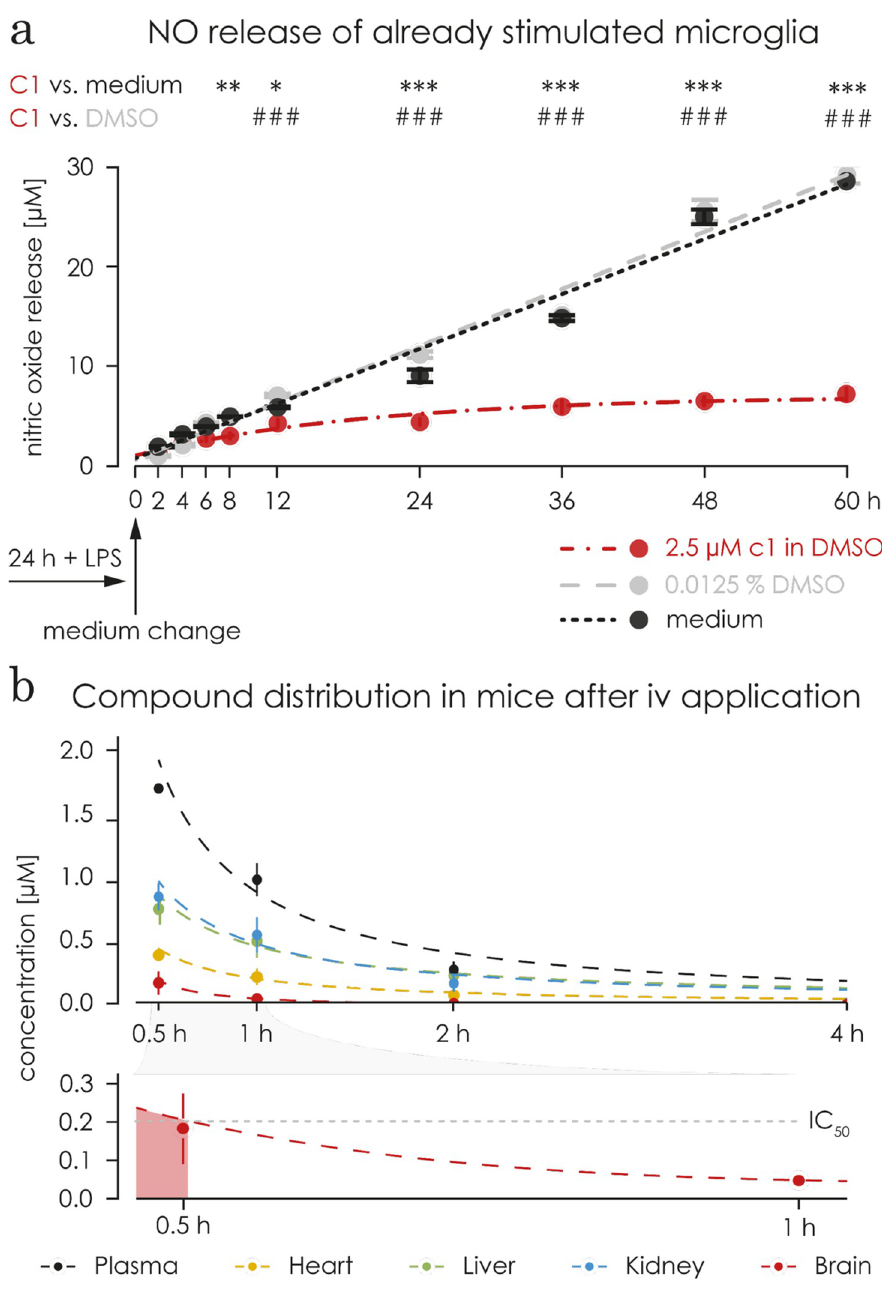
Fig 4. C1 showed an effect on pre-stimulated microglia and passed the blood brain barrier. a) Microglia were stimulated for 24 hours with 1 μ g/mL LPS before being treated with 2.5 μ M C1 (in red), the corresponding concentration of DMSO (125x10 -5 v/v) in plain medium (in grey) or with plain medium only (in black). NO concentration increased linearly in the supernatant of untreated microglia, reaching 28 μ M ( ± 1.036 SEM) after 60 hours. DMSO treatment did not change this linear increase, reaching 29 ± 1.119 μ M at the same time point. Treatment of microglia previously stimulated with LPS with C1 led to an increase in NO concentration to a lower extent over time compared to DMSO and plain medium treatment. The increase in NO concentration followed a one-phase association (R 2 of 0.6498) and reached a calculated plateau of 7 μ M (95% confidence interval 5.999 to 8.127). After 8 hours of treatment with C1, the level of NO was significantly reduced compared to plain medium (p = 0.006), and after 12 hours compared to the cells treated with DMSO (p < 0.0001). ��� p < 0.001 �� p < 0.01 comparing to plain medium control, ### p < 0.001 ## p < 0.01 comparing to DMSO control (non-matching 2way ANOVA followed by Sidak test). b) The upper graph shows the distribution of C1 in different organs after a single intravenous injection into healthy male mice (5 mg/kg, n = 3). The concentration of C1 in blood plasma (in black), heart (in red), liver (in green),